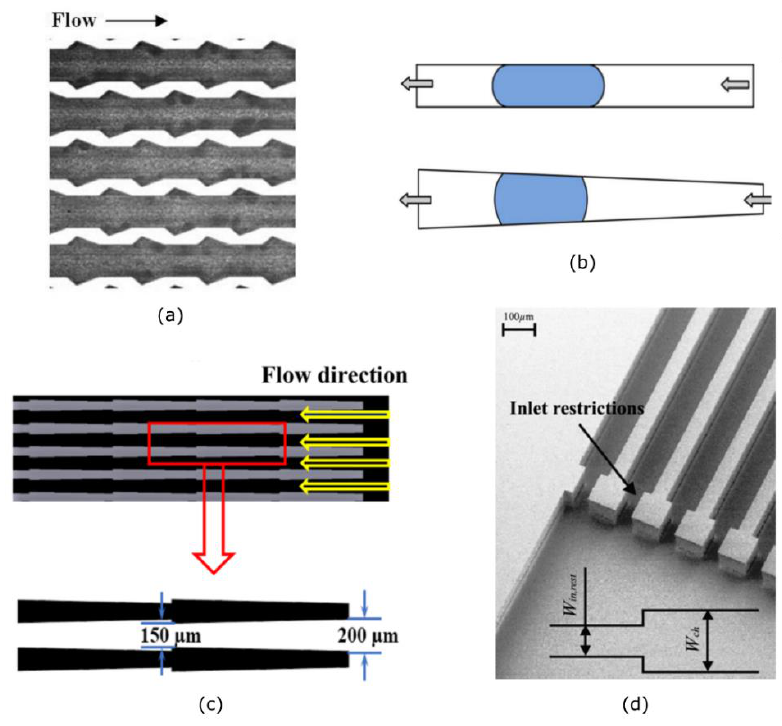
Figure 10. Microchannel geometry modification for boiling heat transfer enhancement: ( a ) triangular configuration [34]; ( b ) divergent configuration [29]; ( c ) saw-tooth configuration [33]; ( d ) inlet restrictors [37].